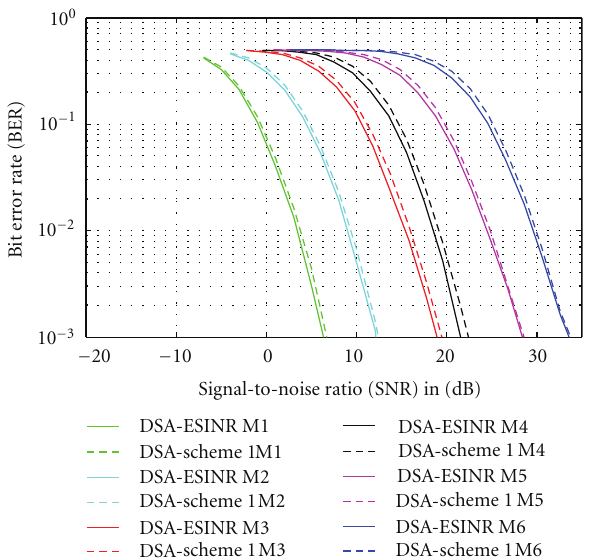
Figure 10: BER comparison between DSA-SINR and DSA-Scheme 1) in “Forced” uncorrelated channel.